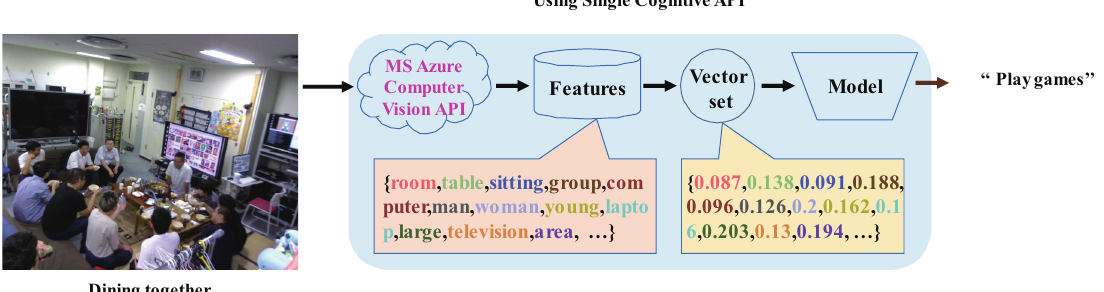
Figure 1. Example of an image with multiple people misrecognized using a single cognitive API.